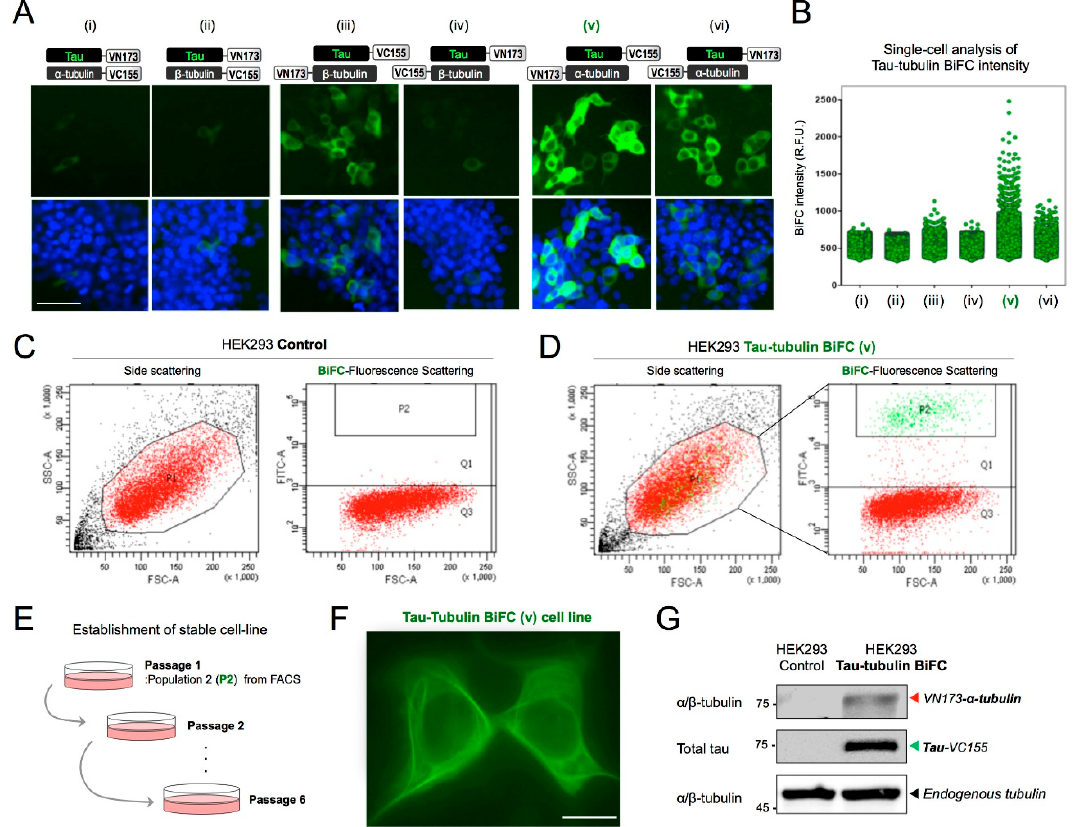
Figure 2. Establishment of the tau-tubulin BiFC cell line. ( A ) BiFC fluorescence images of HEK293 cells transfected with diverse tau- and tubulin-BiFC pairs (i to vi). Scale bar, 50 µ m. ( B ) Single-cell analysis of cellular BiFC intensities. A total of 7000 cells were analyzed for each experiment and each dot represents an individual cell. ( C , D ) Fluorescence-activated cell sorting (FACS) analysis of tau-tubulin BiFC cells. The top 10% of cells exhibiting the highest BiFC fluorescence intensities were sorted (green dots in P2). HEK293 cells were used as a control. ( E ) Experimental scheme for the generation of tau-tubulin BiFC stable cell line. FACS sorted P2 cells were maintained in a growth medium containing G418 for selection and was passaged 6 times. ( F ) High resolution (1000 × ) fluorescence image of tau-tubulin BiFC cells showing tau and tubulin interaction in live cells. Scale bar, 20 µ m. ( G ) Immunoblot analysis of tau-tubulin BiFC cells with tau (S262) and α / β -tubulin antibodies; HEK293 cells were used as a control.